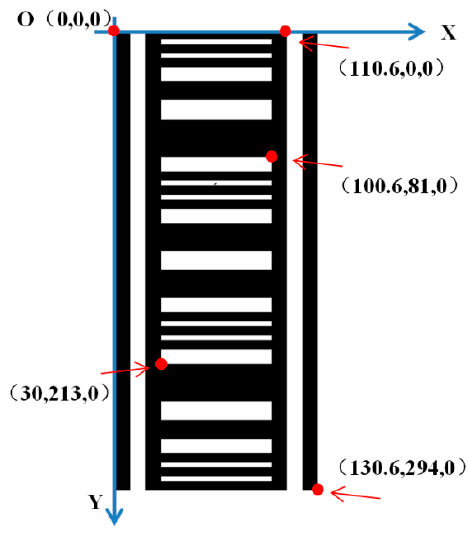
Figure 10. The object coordinate system established using the first point in the top left corner on the bar code as the origin. Some object coordinates of the points marked in red are shown as example.